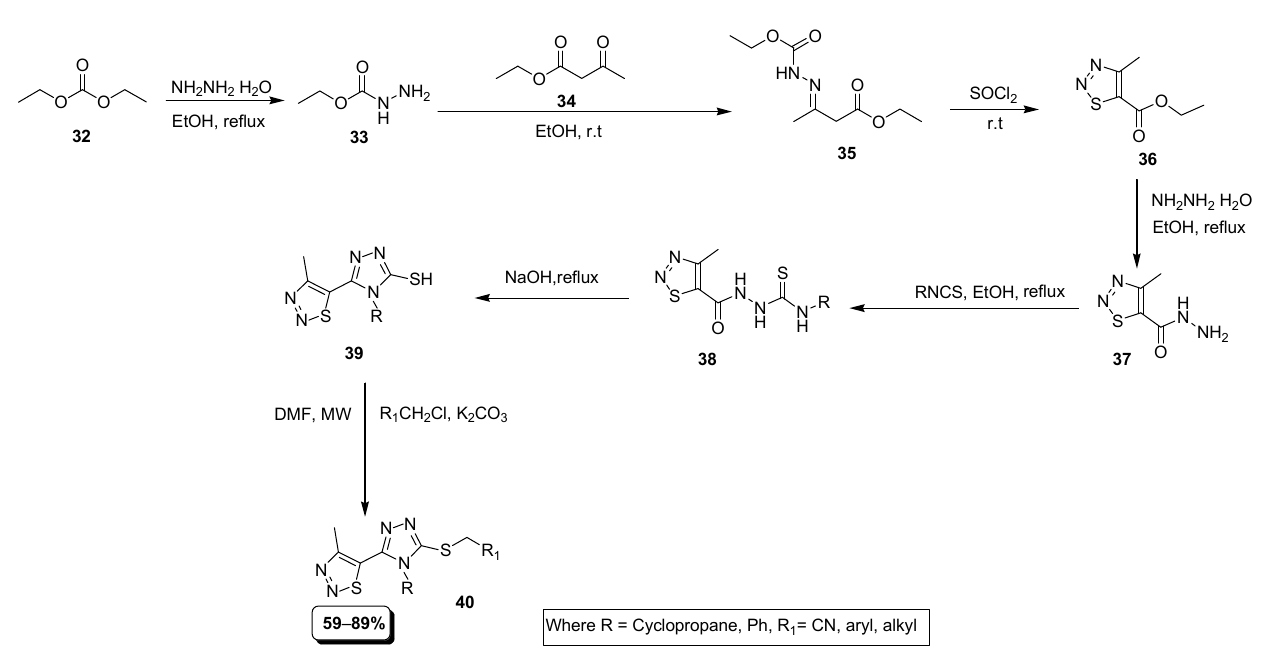
Scheme 6. Synthesis of triazole-based 1,2,3-thiadiazole derivatives ( 49 ). 2.3. Multi Component Synthetic Strategies Zheng et al. developed a simple, convenient and one-step multi-component syn- thetic approach of 1,2,3-thiadiazole via Ugi four-component reaction (U-4CR) (Scheme 7). Where R = Cyclopropane, Ph, R 1 = CN, aryl, alkyl 59 – 89% The first step of this strategy was the generation of imine intermediate by mixing an amine ( 42 ) derivative with aldehyde ( 43 ). In the second step, imine intermediate was treated with thiadiazole ( 41 ) and isocyanide component ( 44 ) to obtain 5-methyl substi- tuted thiadiazole derivatives ( 45 ) in low to excellent (6–98%) yield [83].